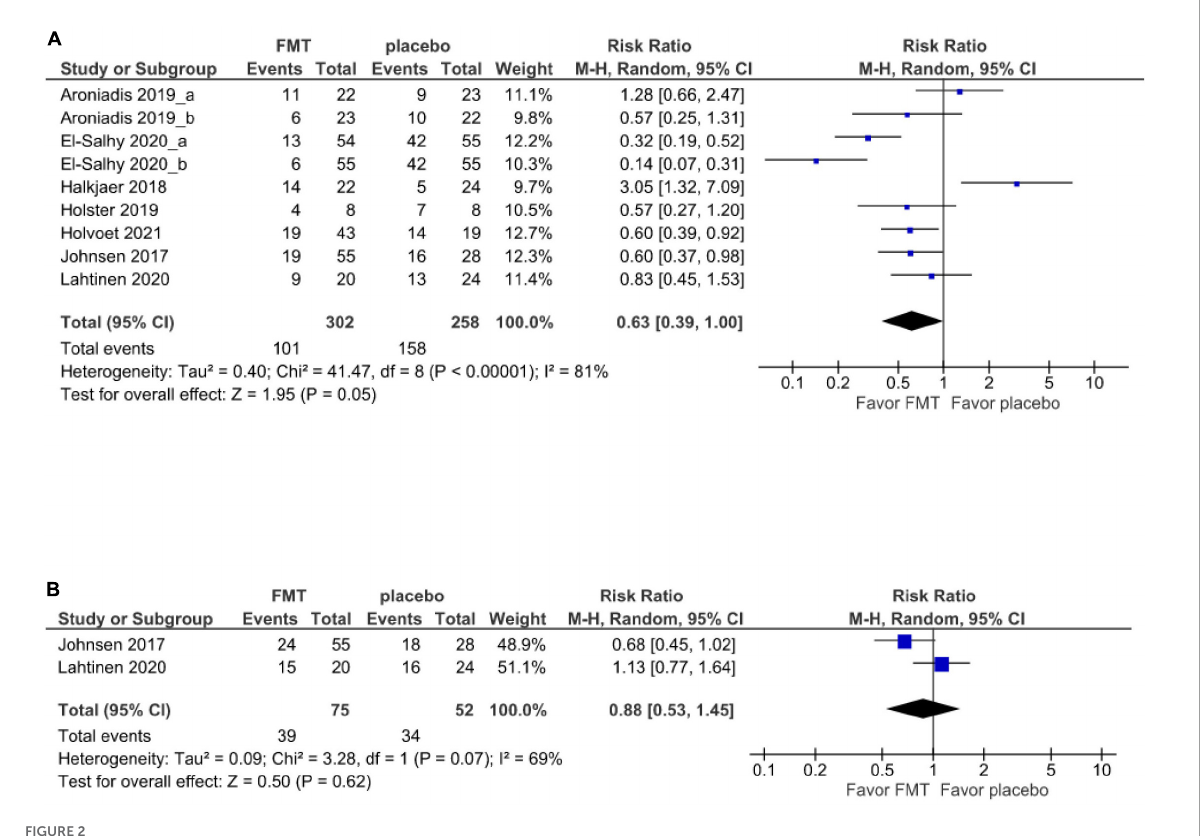
FIGURE2 Forest plot of global symptom of IBS between FMT and placebo. (A) Short term. (B) Long